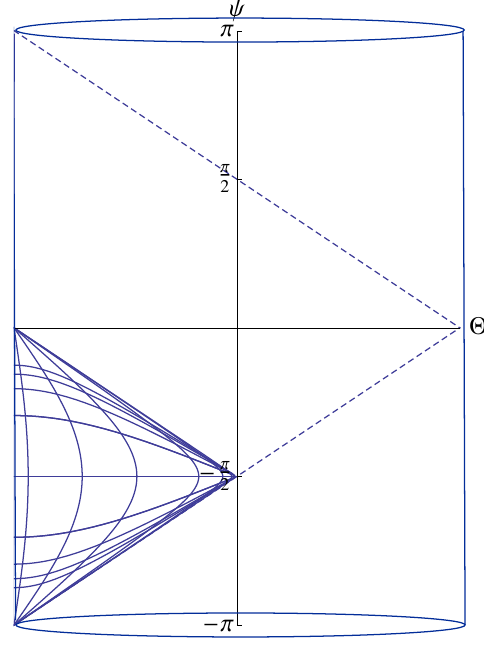
Figure 9. Embedding of the dS patch in global conformal coordinates, tan (cid:2) = sinh (cid:26) , where each point is a d (cid:0) 1 sphere \(cid:12)lled" by (cid:2). The boundary is at (cid:2) = (cid:25)= 2. The dashed lines correspond to the Poincar(cid:19)e patch embedded in global conformal coordinates. The (cid:13)ow endpoint u = 0 is situated on the Poincar(cid:19)e horizon.